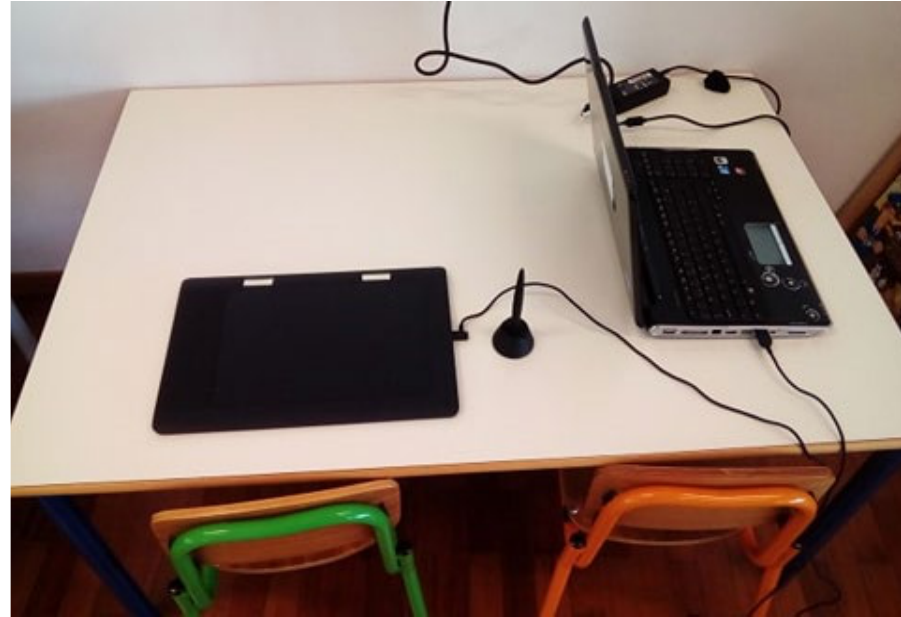
Figure 1. The experimental graphomotor setup with a pen tablet, school desk, and chairs. The experimenter was seated on the right side and could monitor the pen movements in real time on a laptop.